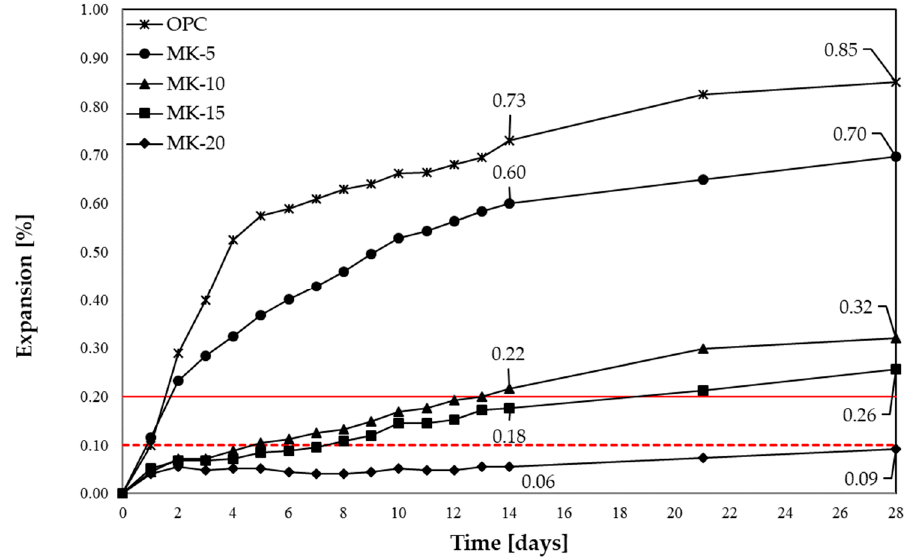
Figure 3. Linear changes of mortars with metakaolin in the accelerated method.